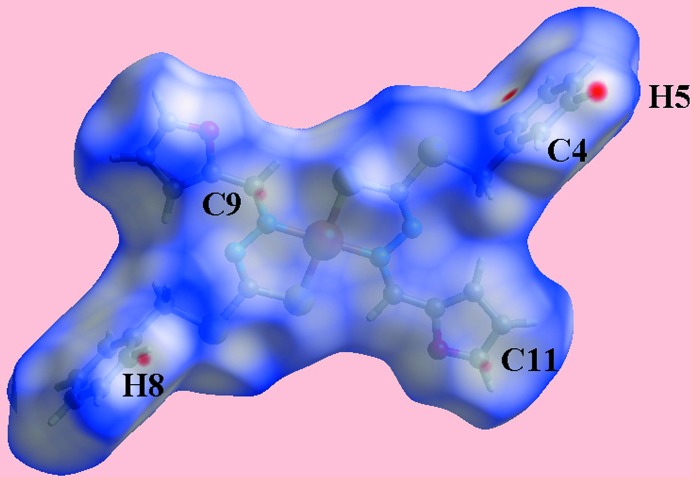
A view of the Hirshfeld surface for (I) mapped over d
norm in the range −0.080 to +1.213 arbitrary units.